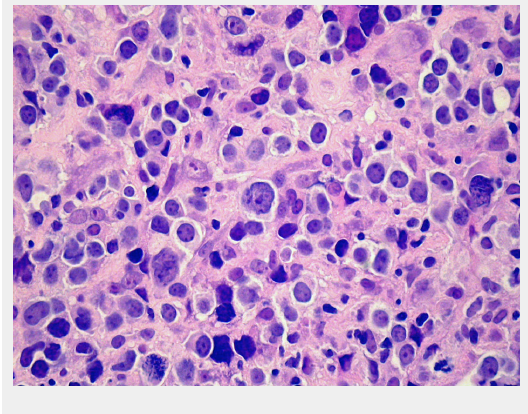
Typical morphological appearance of DLBCL.